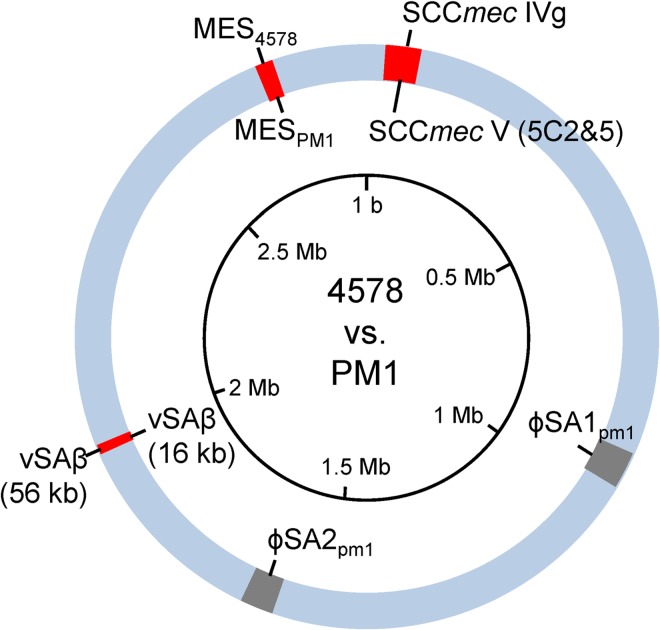
Comparative genomics of 4578 (ST59/SCCmec IVg MRSA) and PM1 (ST59/SCCmec V (5C2&5) MRSA).Information on the 4578 and PM1 genomes is presented outside and inside the genome circle, respectively. Colored regions: blue, conserved region; gray, deletion in strain 4578; red, distinct mobile genetic elements.